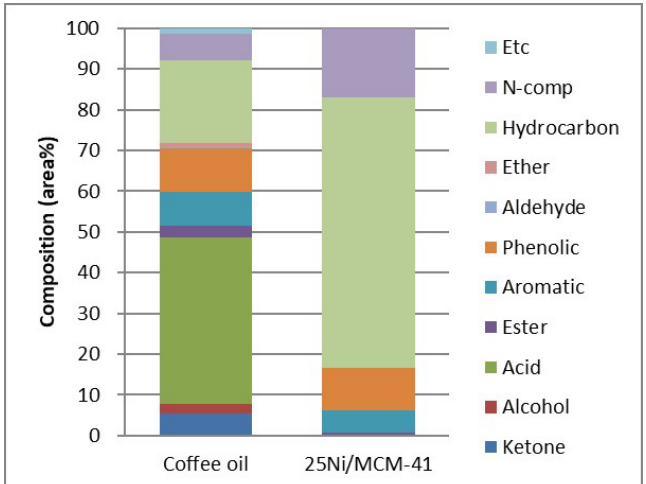
Figure 6. Compositions of coffee biocrude oil and upgraded coffee biocrude oil by catalytic crack- ing according to GC-MS analysis (reaction conditions: biocrude oil = 54 g, Ni/MCM-41 = 6 g, temperature = 400 ◦